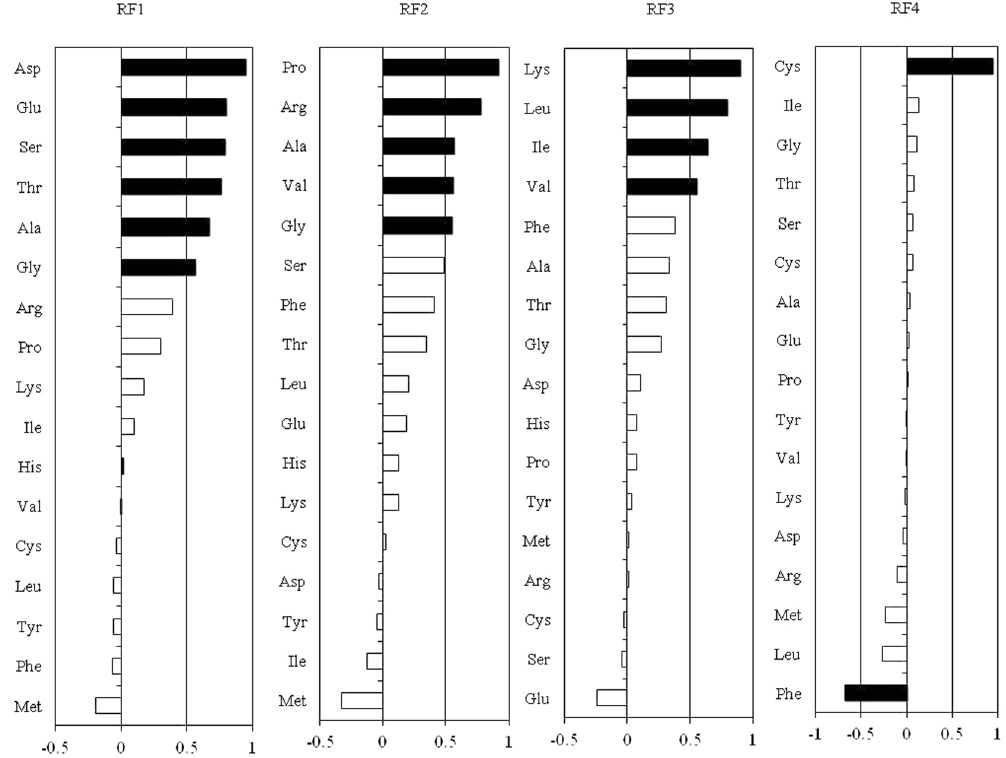
Figure 6. Loadings for each individual amino acid of Festuca arundinacea onto the first four rotated factors (RF). The individual amino acids loading heavily either positively (loading ≥ + 0.5) or negatively (loading ≤ − 0.5) are highlighted in